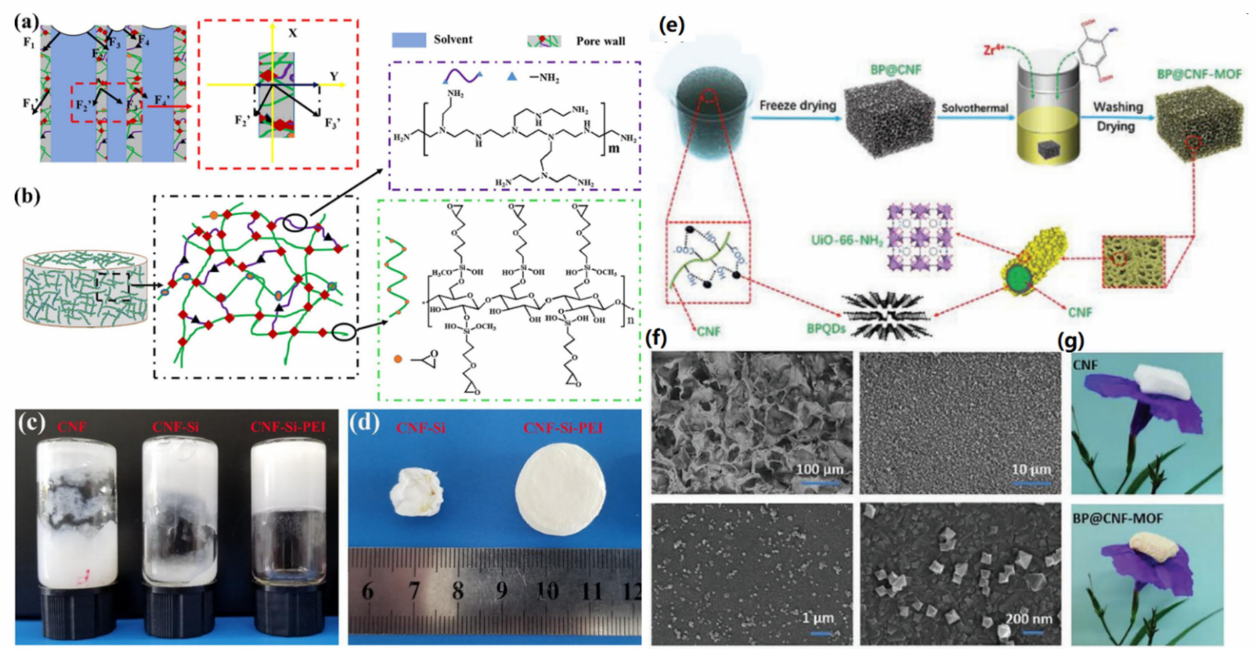
Figure 4. Fabrication of CNF-based aerogels. ( a – d ) CNF and CNF/PEI aerogels: ( a ) stress analysis, ( b ) cross-inking for the formation of aerogels, ( c ) gels after freeze-thawing, and ( d ) aerogels after drying. Reproduced with permission from Ref. [61], Copyright 2019, Elsevier Ltd. ( e – g ) BP@CNF-MOF aerogels: ( e ) synthesis strategy, ( f ) SEM characterizations, and ( g ) photographs of CNF and BP@CNF-MOF aerogels. Reproduced with permission from Ref. [32], Copyright 2021, Wiley